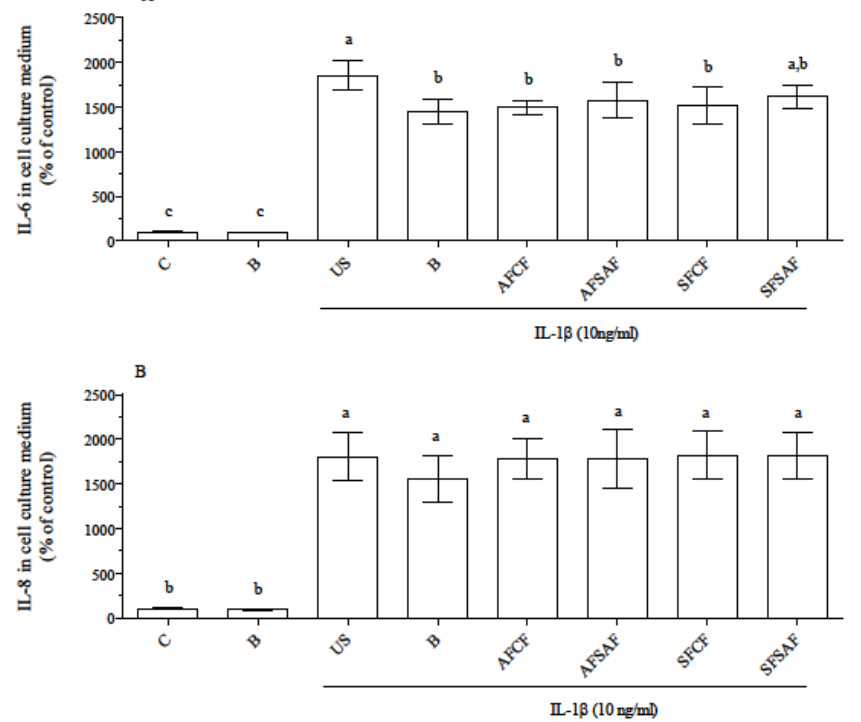
Figure 5. IL-6 ( A ) and IL-8 ( B ) secretion in basal condition and after IL-1 β stimulation. Data are means ± SD of at least 4 samples derived from 2 independent experiments, and are expressed as the percentage of the value obtained in control, not stimulated cells (assigned as 100%). Different letters indicate statistical significance ( p < 0.05). C = control, B = supplemented with blank digesta; US = unsupplemented; AF = ancient flour; SF = standard flour; CF = conventional fermentation; SAF = sourdough obtained from ancient flour; SSF = sourdough obtained from standard flour.